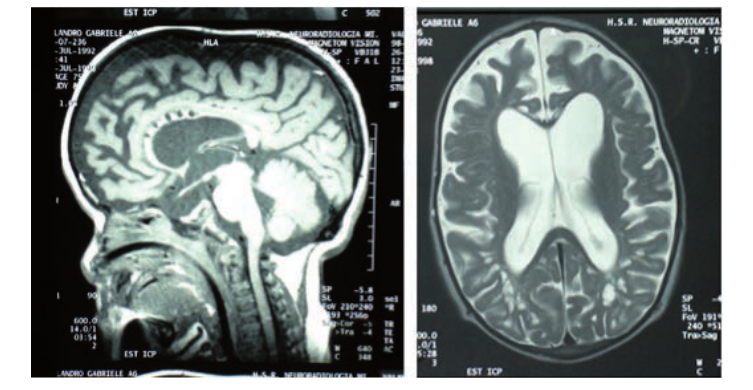
Figure 7. Brain atrophy, gliosis, white matter changes in 10-year old mucopolysacchari- dosis type I Hurler patient receiving only palliative